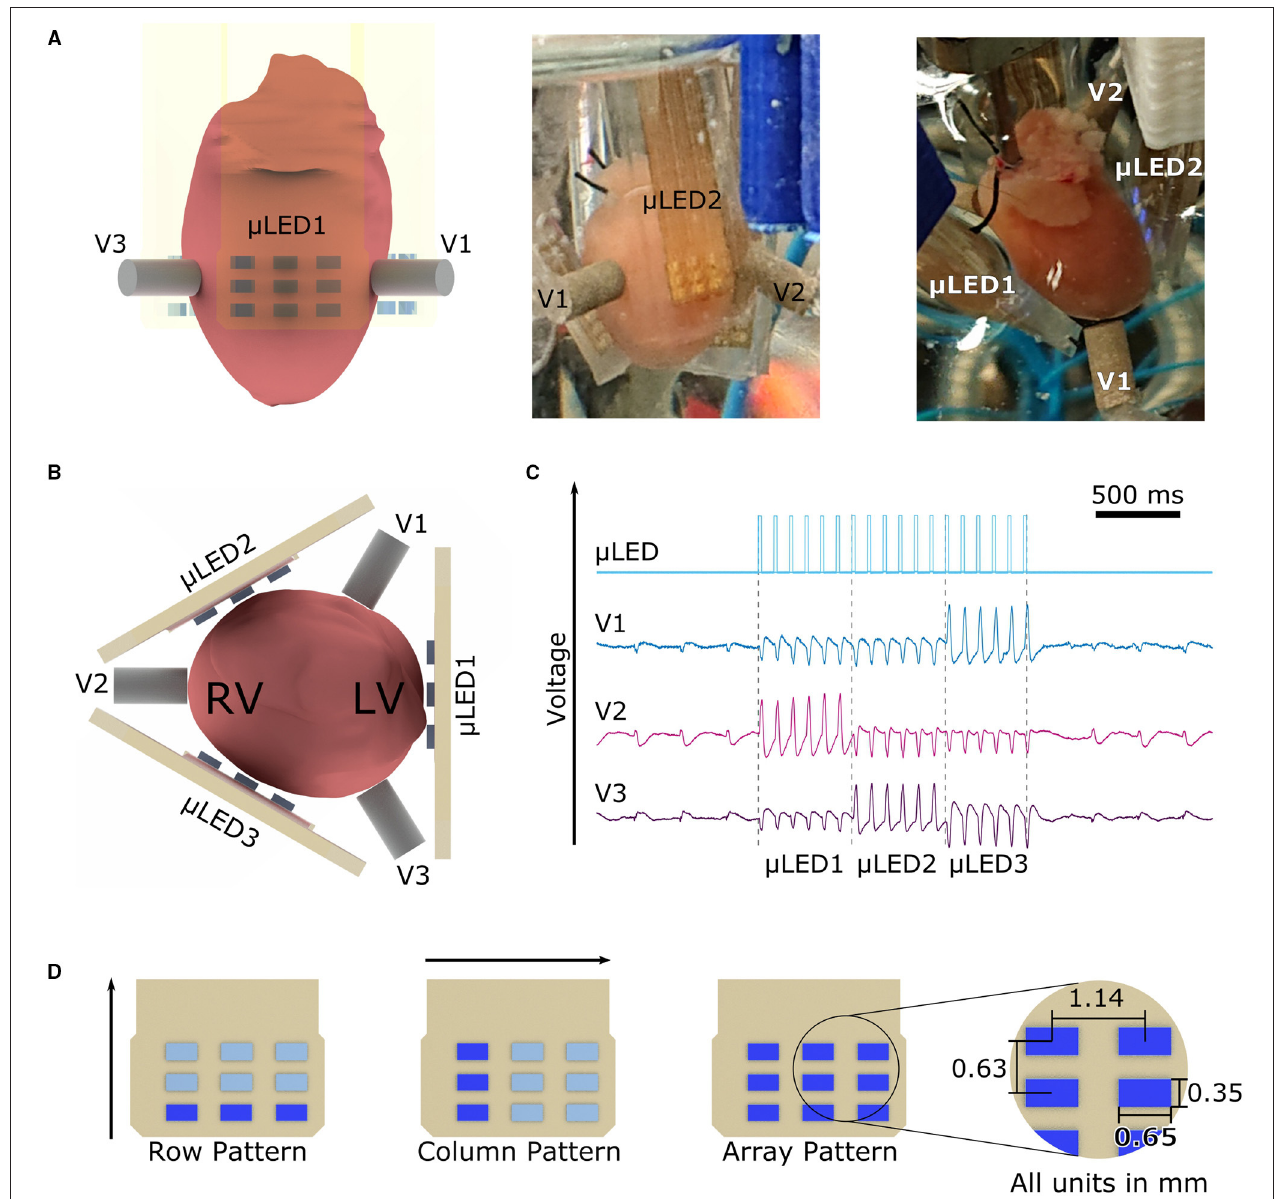
FIGURE 1 | Experimental setup with three lead ECGs, three µ LED arrays, and illumination patterns used. (A) The murine heart was encompassed by three µ LED arrays and three ECG Electrodes as shown in all panels from different angles. (B) µ LED1 was always positioned onto the left ventricle of the heart, following µ LED arrays were positioned with a 120 ◦ angle with respect to each other. In a similar way, the ECG electrodes V1, V2, and V3 are positioned in the space between µ LED arrays. (C) ECG recording showing the photostimulation given by the µ LED array and the corresponding responses measured by V1, V2, and V3 electrodes. The change of polarity, as well as the change in amplitude, demonstrate that the chosen measuring electrode registers the highest potential when the opposite µ LED array is activated (D) Applied illumination patterns. The row pattern initiates illumination in the lower row of every array at the given frequency and pulse width, the column pattern starts with the left column and rotates around the heart with the parameters set. The array pattern activated the nine µ LEDs at the same time in µ LED1 then turned off after the given pulse width, similarly, µ LED2 was then activated, and finally µ LED3 irradiated the heart at last. The spacing of the µ LED in x-direction is 1.14mm and in y-direction is